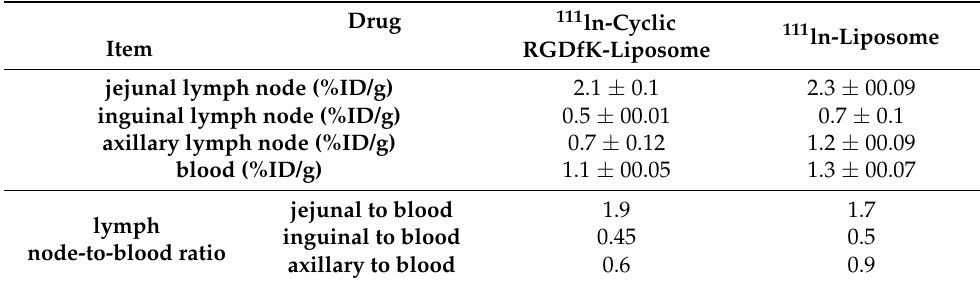
Table 3. The percentage of injection dose per gram (%ID/g) of the 111 ln-cyclic RGDfK-liposome or the 111 ln-liposome in lymph nodes and the radioactivity proportion of lymph nodes to blood in the mice without human melanoma